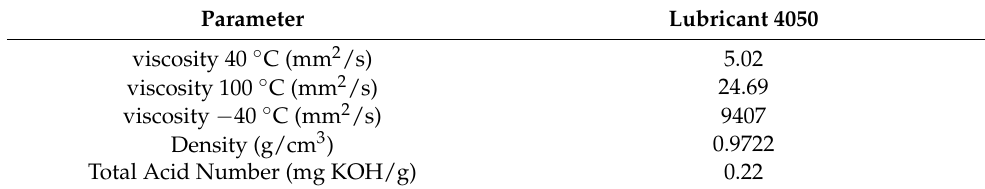
Table 1. Lubricant parameters of the lubricant 4050 used in this